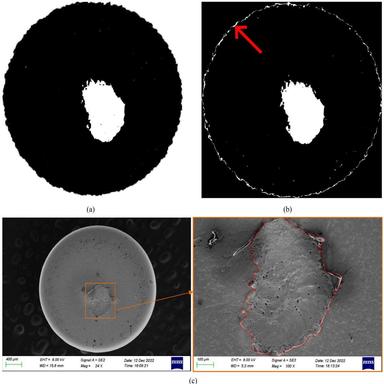
Erosion region identified by different methodologies. (a) Proposed algorithm in this paper. (b) Whale optimization algorithm. (c) Actual SEM picture.